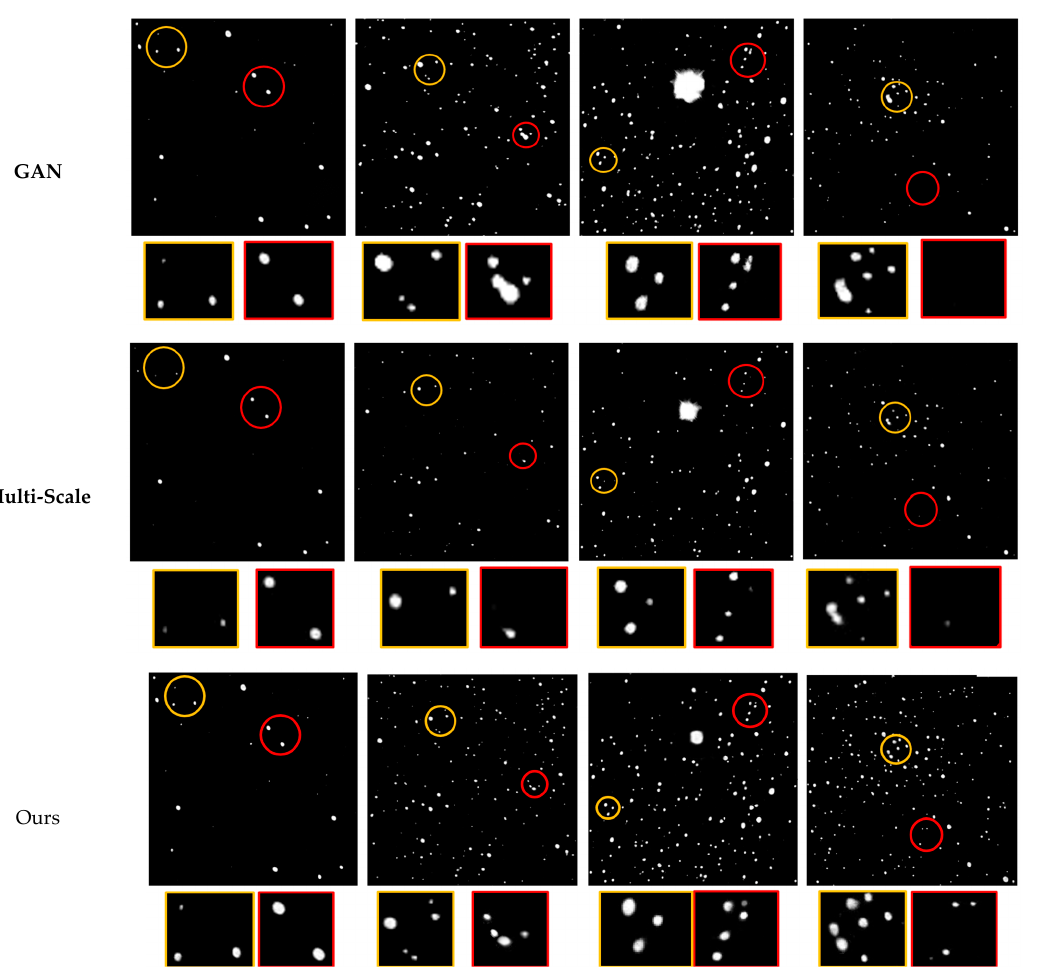
Figure 11. Use di ff erent methods to restore the results of real astronomical images. Each column Figure 11. Use different methods to restore the results of real astronomical images. Each column represents a method, and each row inputs the same set of images. represents a method, and each row inputs the same set of images.